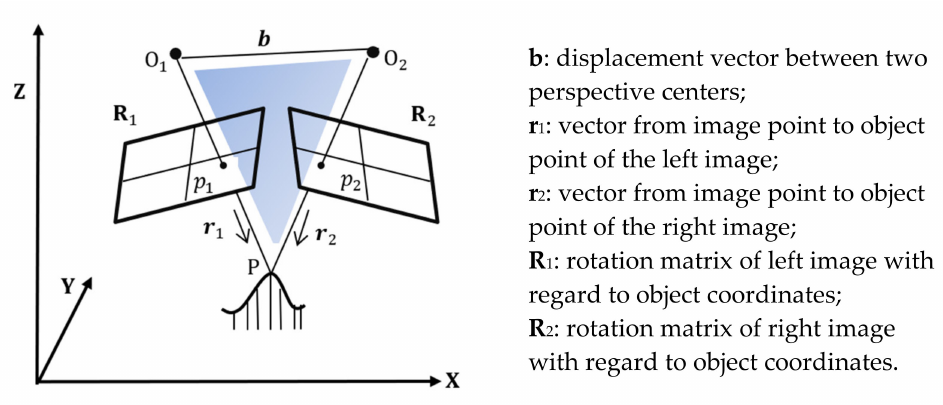
Figure 17. Basic principle of 3D point reconstruction using images: geometry of